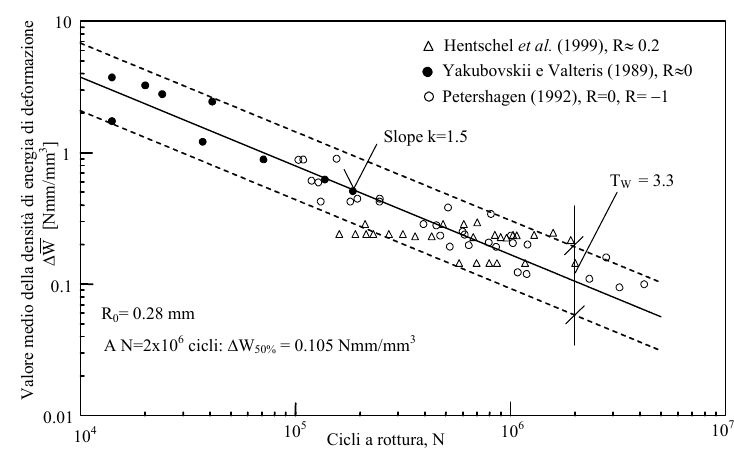
Figura 4: Resistenza a fatica di giunti saldati testa a testa in funzione del valore medio della densità di energia di deformazione [20]; confronto con la banda di dispersione riportata in [11].